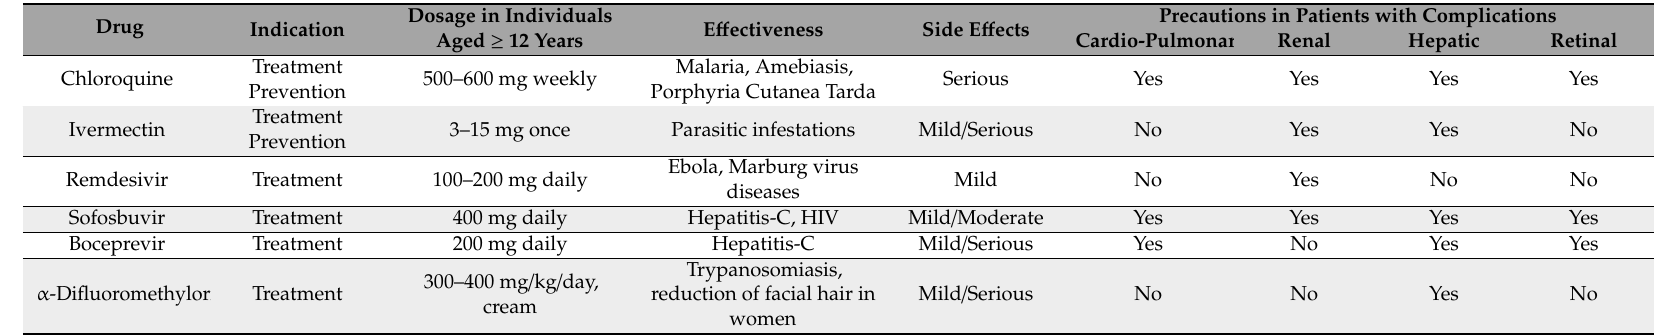
Table 1. Comparison of existing drugs currently being tested for the antiviral treatment and prevention of COVID-19 through drug